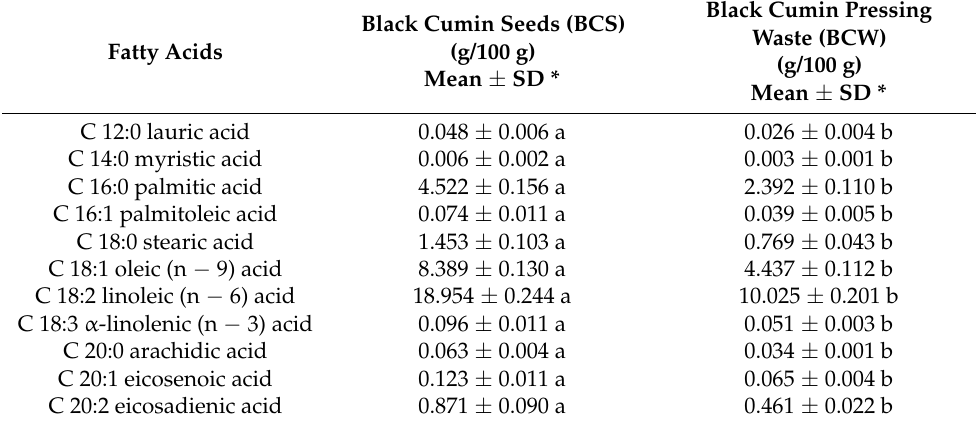
Table 1. Composition of fatty acids in black cumin (BCS) seeds and black cumin pressing waste (BCW).